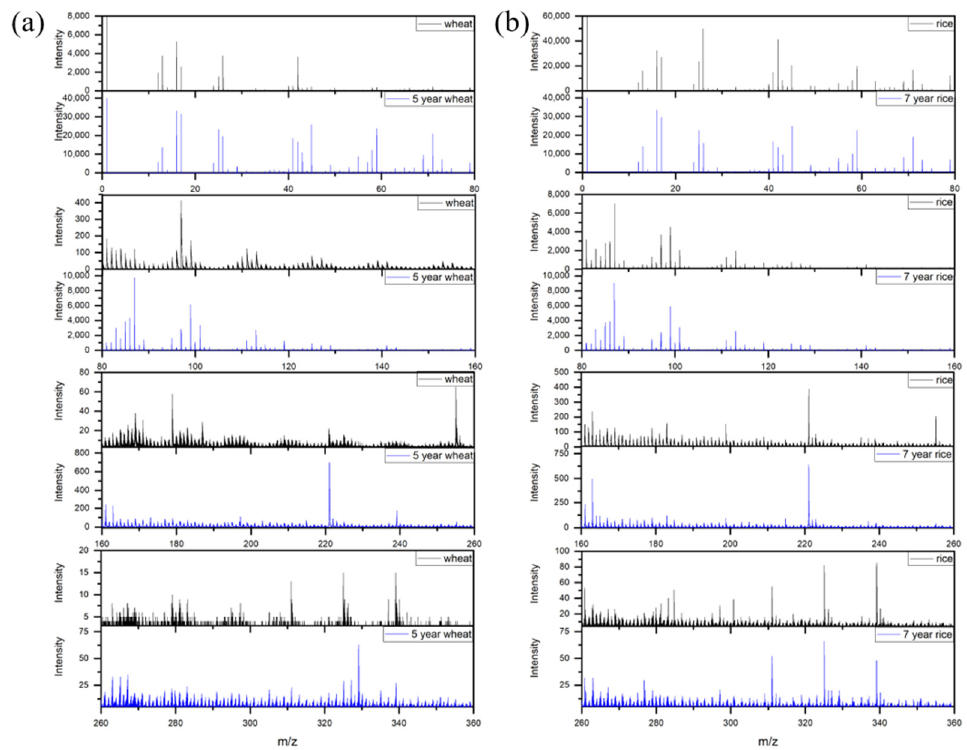
Figure 6. The negative ion ToF-SIMS spectra of: ( a ) fresh wheat starch and 5-year fermented wheat starch; and ( b ) rice starch and 7-year fermented rice starch in the mass range, m / z 0–360.